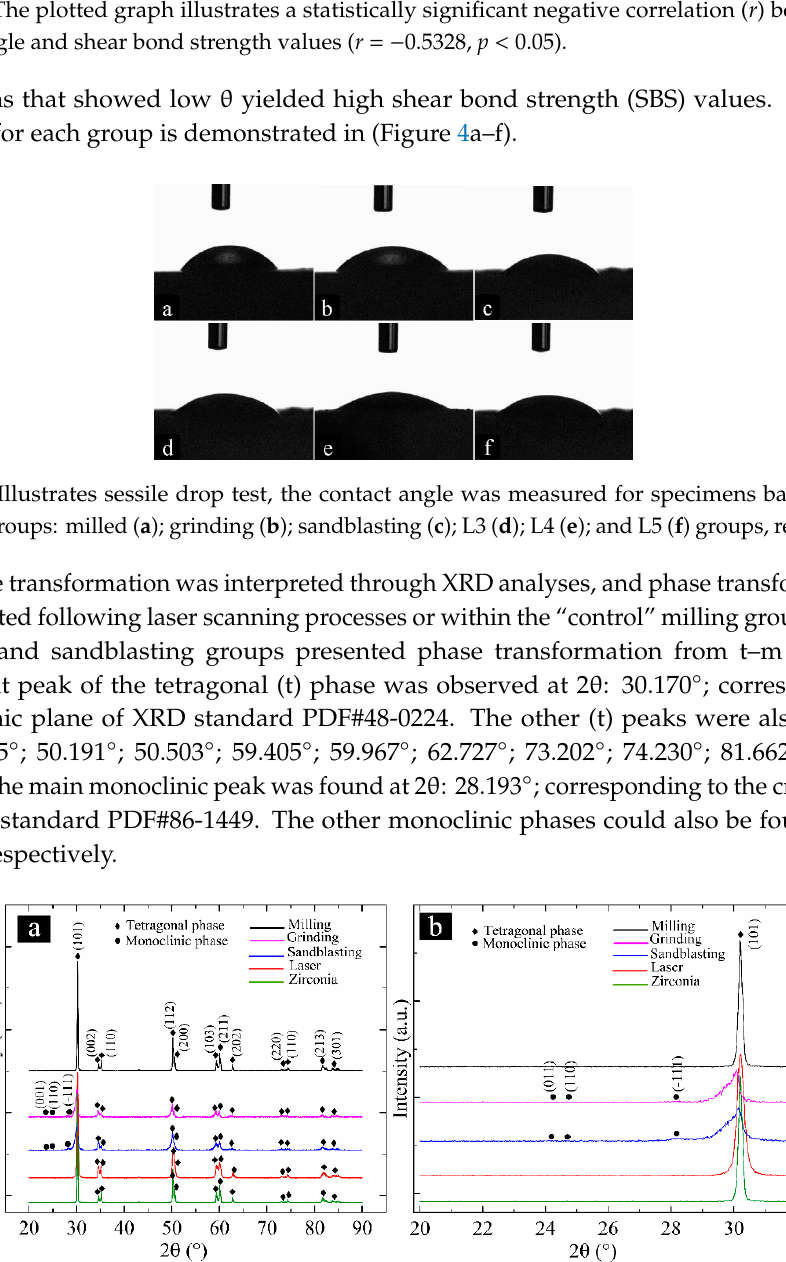
Figure 5. XRD showing crystallographic peaks; full scale ( a ) and enlarged scale ( b ). The core material shows different peaks following milling, grinding, sandblasting, laser scanning and zirconia without surface treatment.